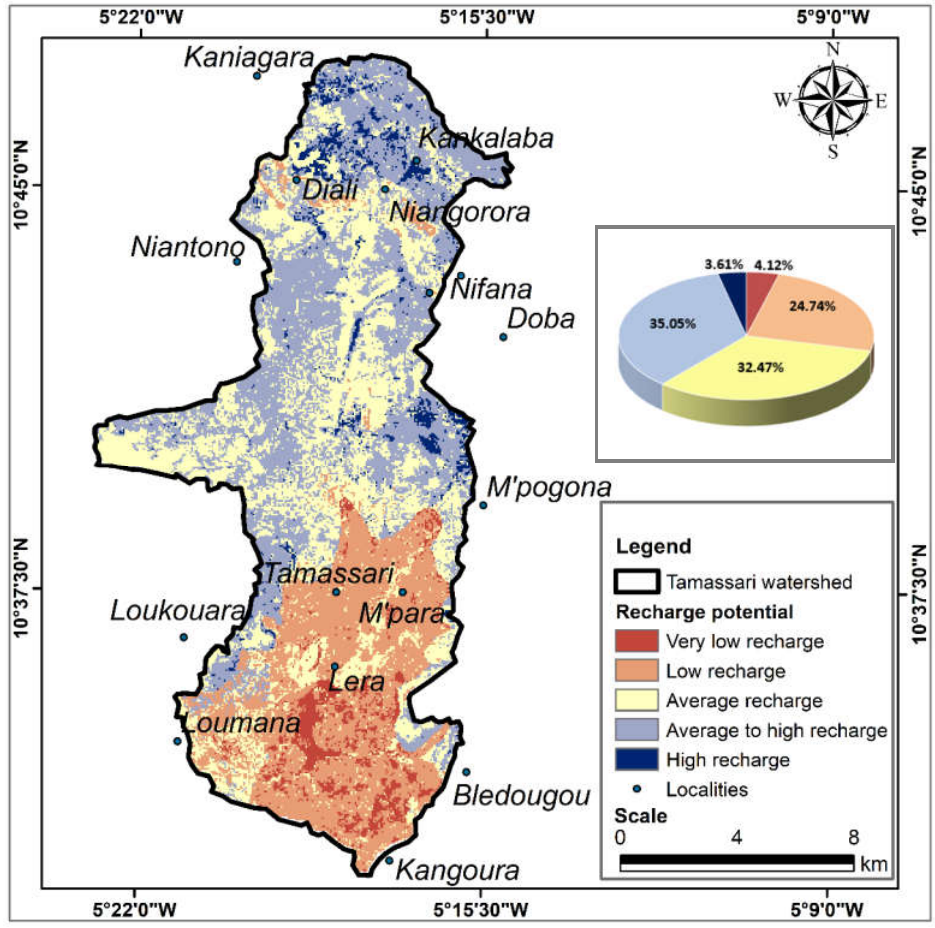
Figure 15. Recharge potential map of the Tamassari basin by the AHP method.